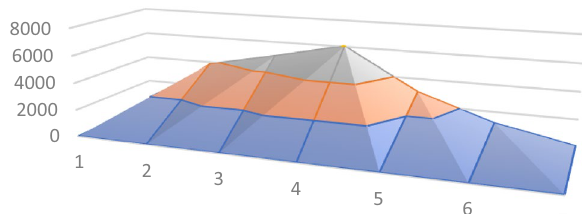
Fig. 7 Suitability classes (S1-S7)